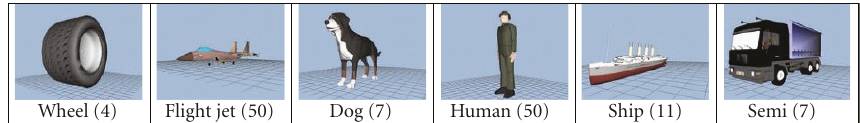
Figure 6: OMDB2: the semantic name and the object number for some classes of base classification.